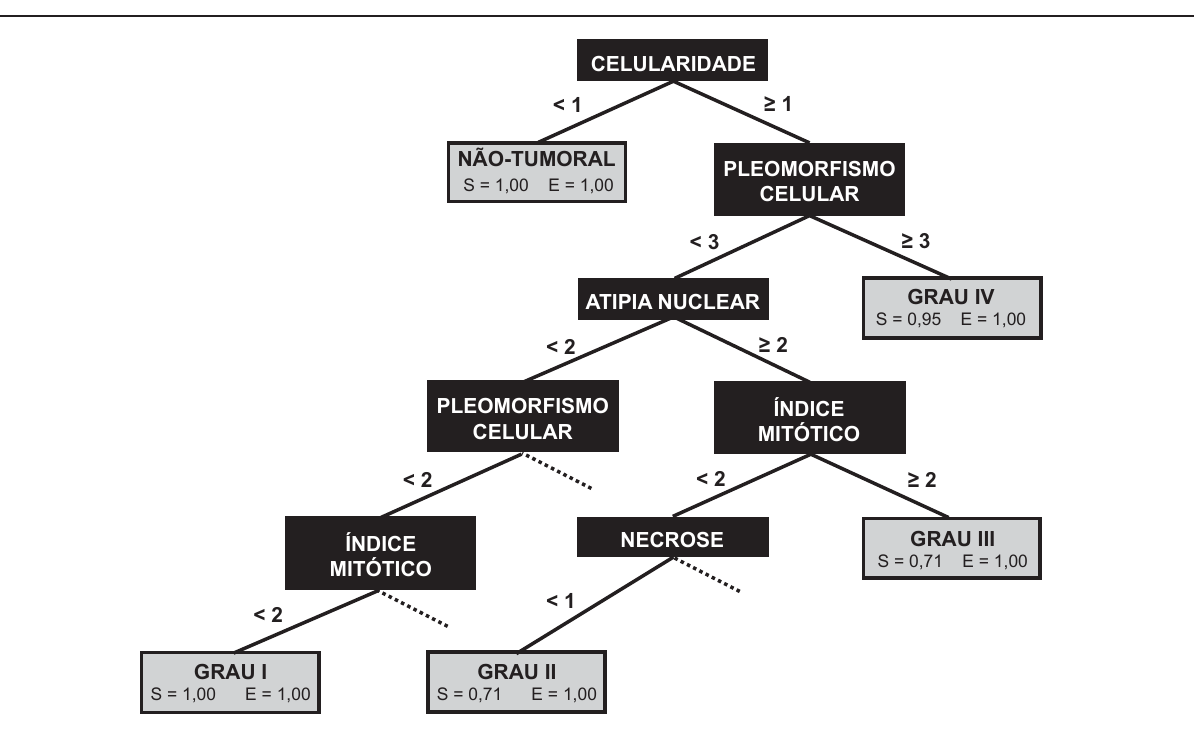
Figura 4 – Árvore de decisão fornecida pelo método CART referente à análise dos achados histopatológicos de acordo com a classificação histológica dos casos avaliados. Custo relativo total: 0,192; S: sensibilidade; E: especificidade.